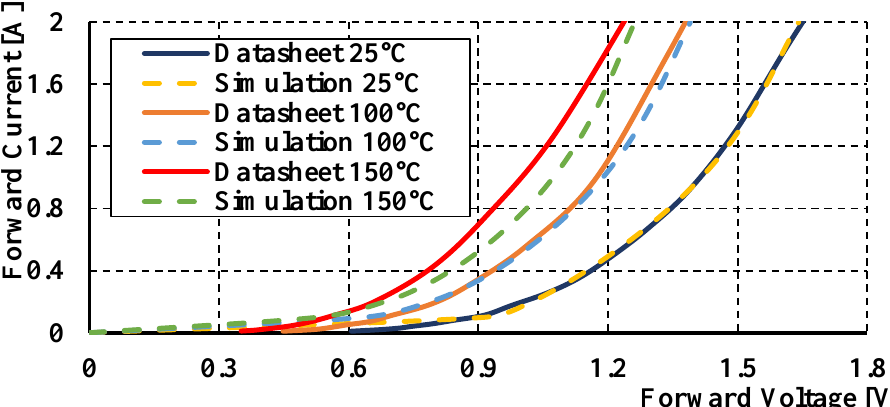
Figure 11. Simulated VA characteristics (dotted line) compared to VA characteristics from datasheet (full line).